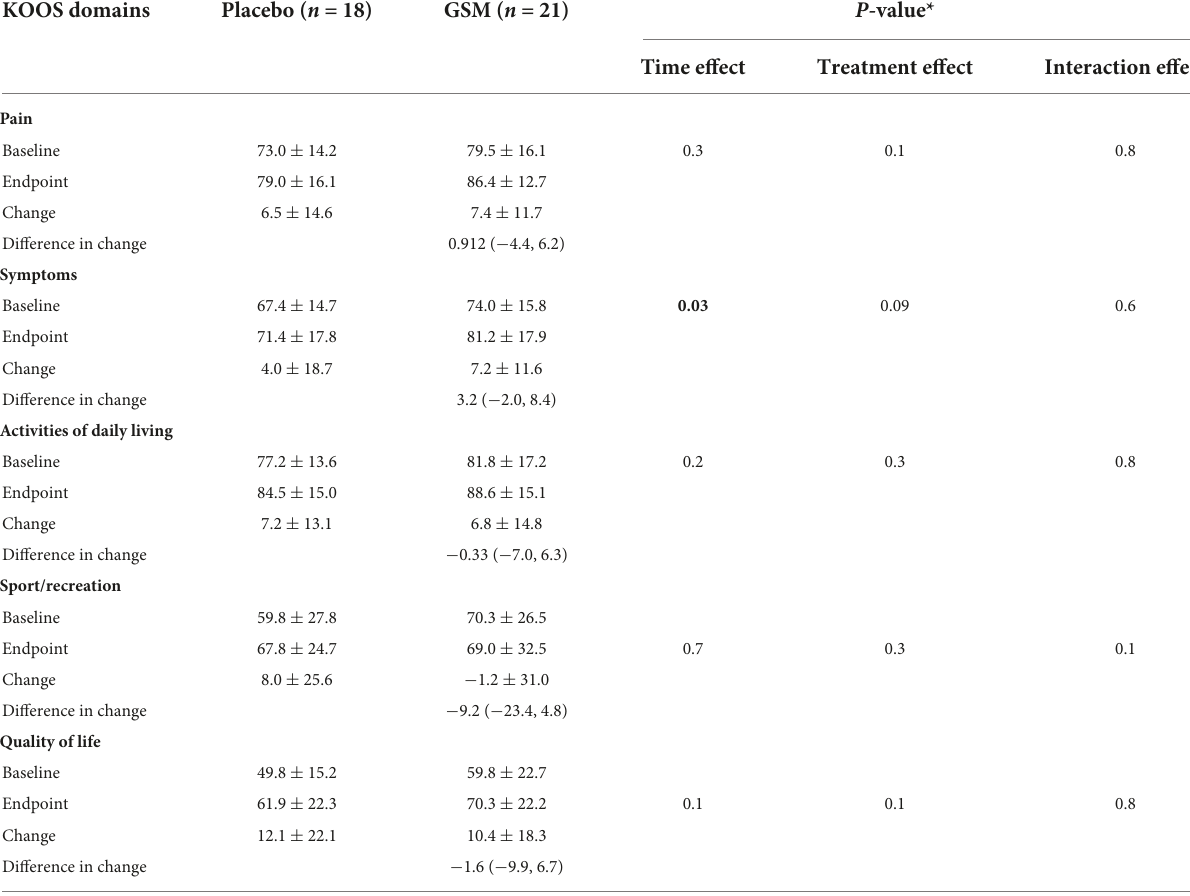
TABLE 2 Mean ± SD of knee injury and osteoarthritis outcome score (KOOS) domain scores over the 12 weeks of study across treatment groups 1 . KOOS domains Placebo ( n =